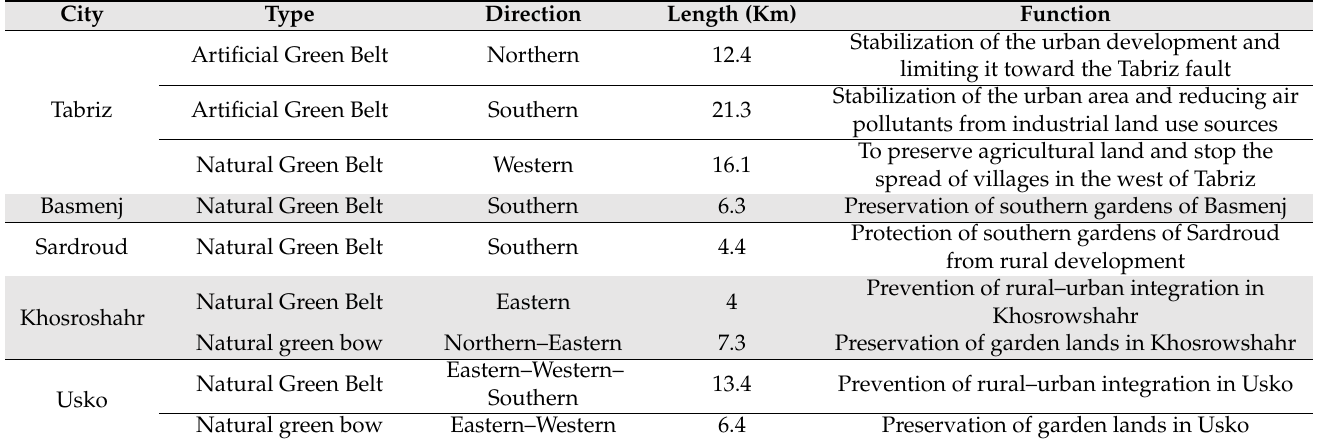
Table 12. Proposed ecological green belt and bow policies for nature-based